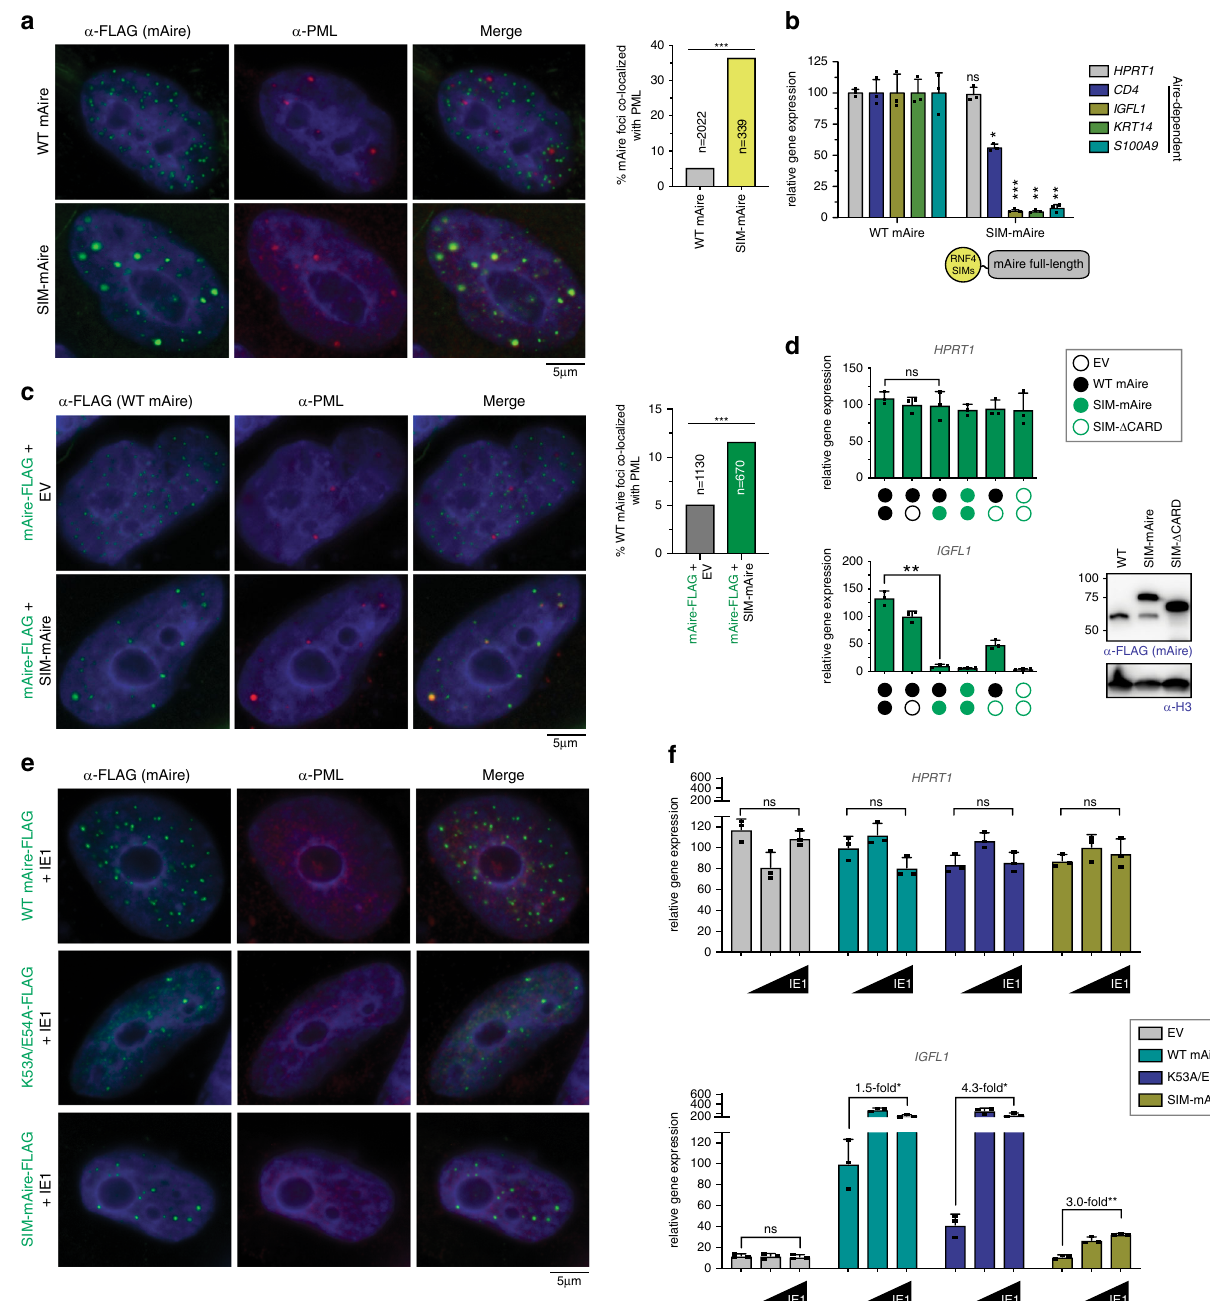
Fig. 4 Directing Aire to PML bodies inhibits transcriptional activity, while dispersing PML bodies increases Aire activity. a Representative fl uorescence microscopy images of FLAG-tagged WT mAire and mAire N-terminally fused with SUMO interaction motifs (SIMs) from RNF4 (SIM-mAire). Right, quanti fi cation of Aire foci colocalized with endogenous PML bodies. n = number of Aire foci examined per sample. *** p (two-tailed Student ’ s t -test) = 1.68e-71. b Transcriptional activity of mAire and SIM-mAire. Experiments are presented as mean ± s.d., n = 3. P -values (two-tailed t -test) were calculated in comparison to WT mAire where * p = 0.031; ** p = 0.0035 and 0.0014 for KRT14 and S100A9 respectively; *** p = 0.0004; p = 0.68 is not signi fi cant (ns). c Representative fl uorescence microscopy images of WT mAire-FLAG with and without co-expression with SIM-mAire (no tag) in 4D6 cells. Right, quanti fi cation of the Aire foci colocalized with endogenous PML bodies as in ( a ). *** p (two-tailed Student ’ s t -test) = 4.39e-7. d Transcriptional activity of mAire (black circle) with and without co-expression of SIM-mAire (green circle) in 293 T cells. Each circle represents 0.6 μ g/ml DNA transfected. Experiments are presented as mean ± s.d., n = 3. See Supplementary Fig. 4a for additional Aire-dependent target genes. P -values (two-tailed t -test) were calculated in comparison to WT mAire where ** p = 0.002; p = 0.88 is not signi fi cant (ns). e Representative fl uorescence microscopy images of FLAG- tagged mAire co-expressed with CMV IE1 (0.5 μ g/ml DNA each construct) in 4D6 cells. Cells were immunostained with anti-FLAG and anti-PML. See Supplementary Fig. 4c for the impact of IE1 on PML body dispersion. f Transcriptional activity of mAire, K53A/E54A and SIM-mAire (0.5 μ g/ml DNA) with an increasing concentration of IE1 (0, 0.17, 0.5 μ g/ml) in 293 T cells. Values are normalized against WT mAire without IE1. Experiments are presented as mean ± s.d., n = 3. Fold-changes in transcriptional activities upon addition of IE1 are indicated. P -values (two-tailed t -test) were calculated in comparison to no IE1. * p < 0.05; ** p < 0.01; p > 0.05 is not signi fi cant (ns). Exact p -values are provided in the Source Data